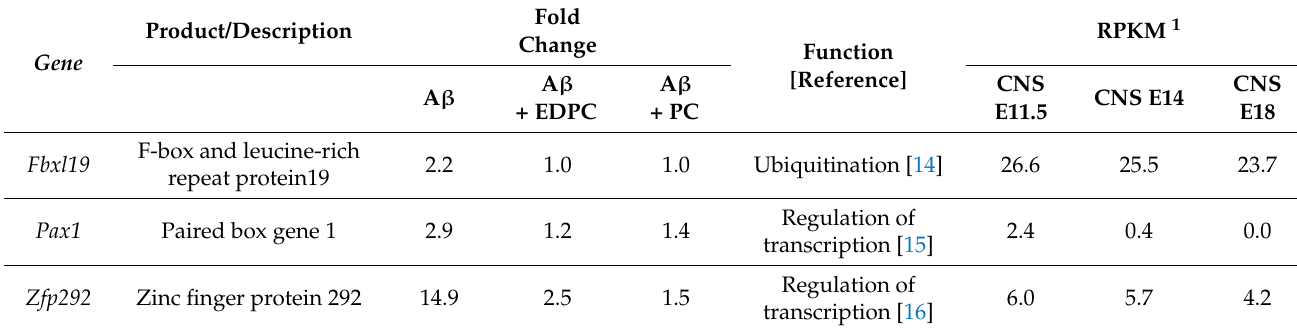
Table 3. Fold change values of the downregulated EDPC-related genes with respect to the sham group.